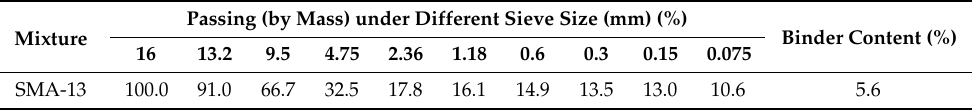
Table 3. Gradation of SMA for testing.